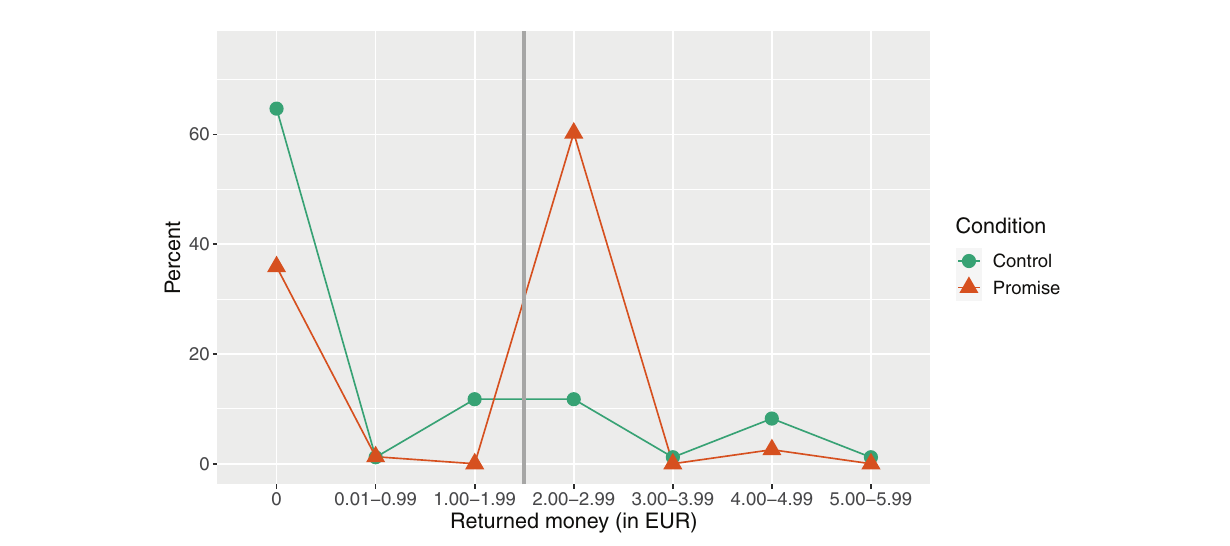
FIGURE1 Return choices of participants in both conditions who opted for the higher payment. The x-axis shows returned amounts of money (in intervals). Participants received a score of “0” if they returned an empty envelope, returned no envelope at all, or returned other things (e.g., a 100 Kronen bill). Note that two participants in the control condition returned more than the e 4-endowment that they had received as part of the experiment. Any returned amount of e 2 or more fulfilled the promise in the promise condition (indicated by the vertical, gray